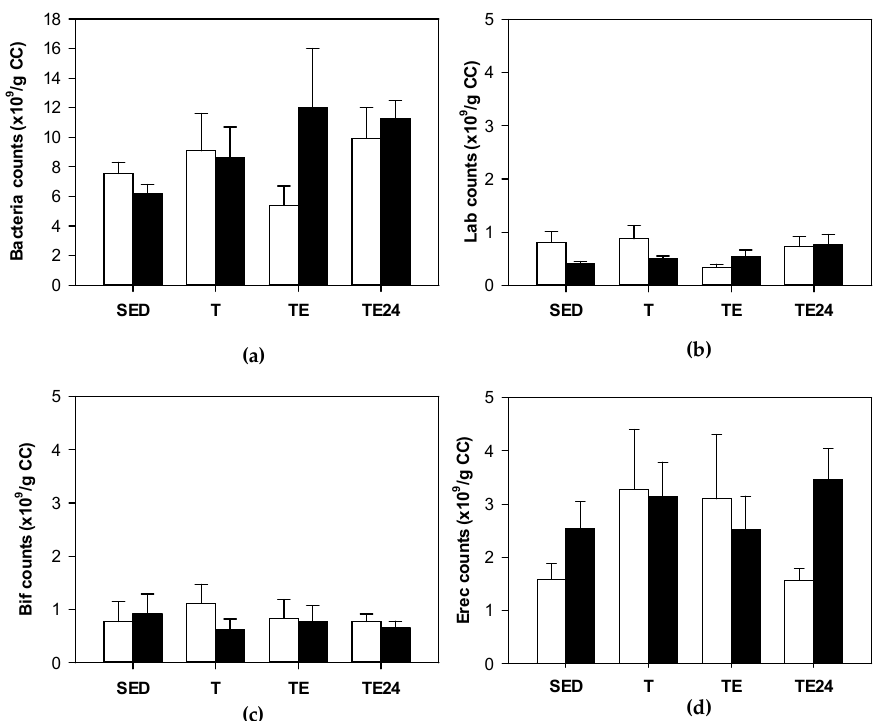
Figure 2. Total bacteria (counts ×10 9 /g cecal content) ( a ); Lactobacillus (counts ×10 9 /g cecal content) ( b ); Bifidobacterium (counts ×10 9 /g cecal content) ( c ); Clostridium coccoides/Eubacterium rectale (counts ×10 9 /g cecal content) ( d ). The non-supplemented groups are represented by white bars and the hesperidin-supplemented groups by black bars. CC = cecal content; SED = sedentary groups; T = trained groups; TE = T groups with an additional exhaustion test; TE24 = TE groups 24 h after the exhaustion test. Data are expressed as mean ± SEM ( n = 8).